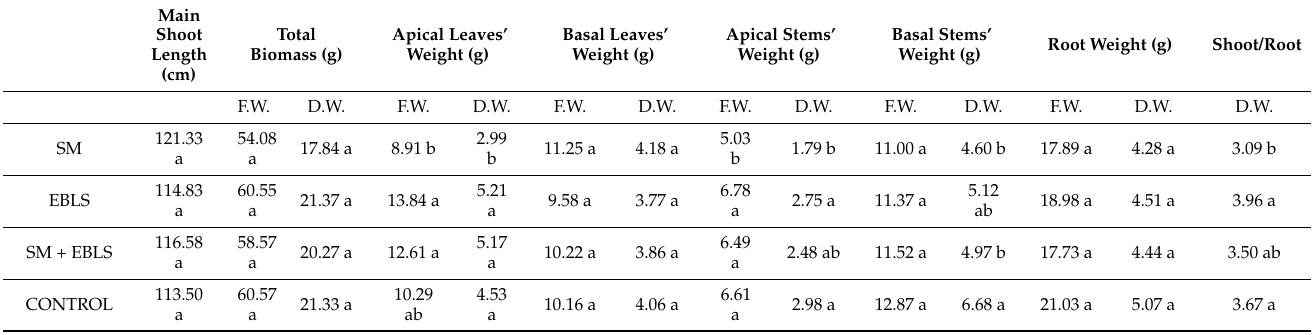
Table 3. Growth parameters of the olive plants among the treatments.